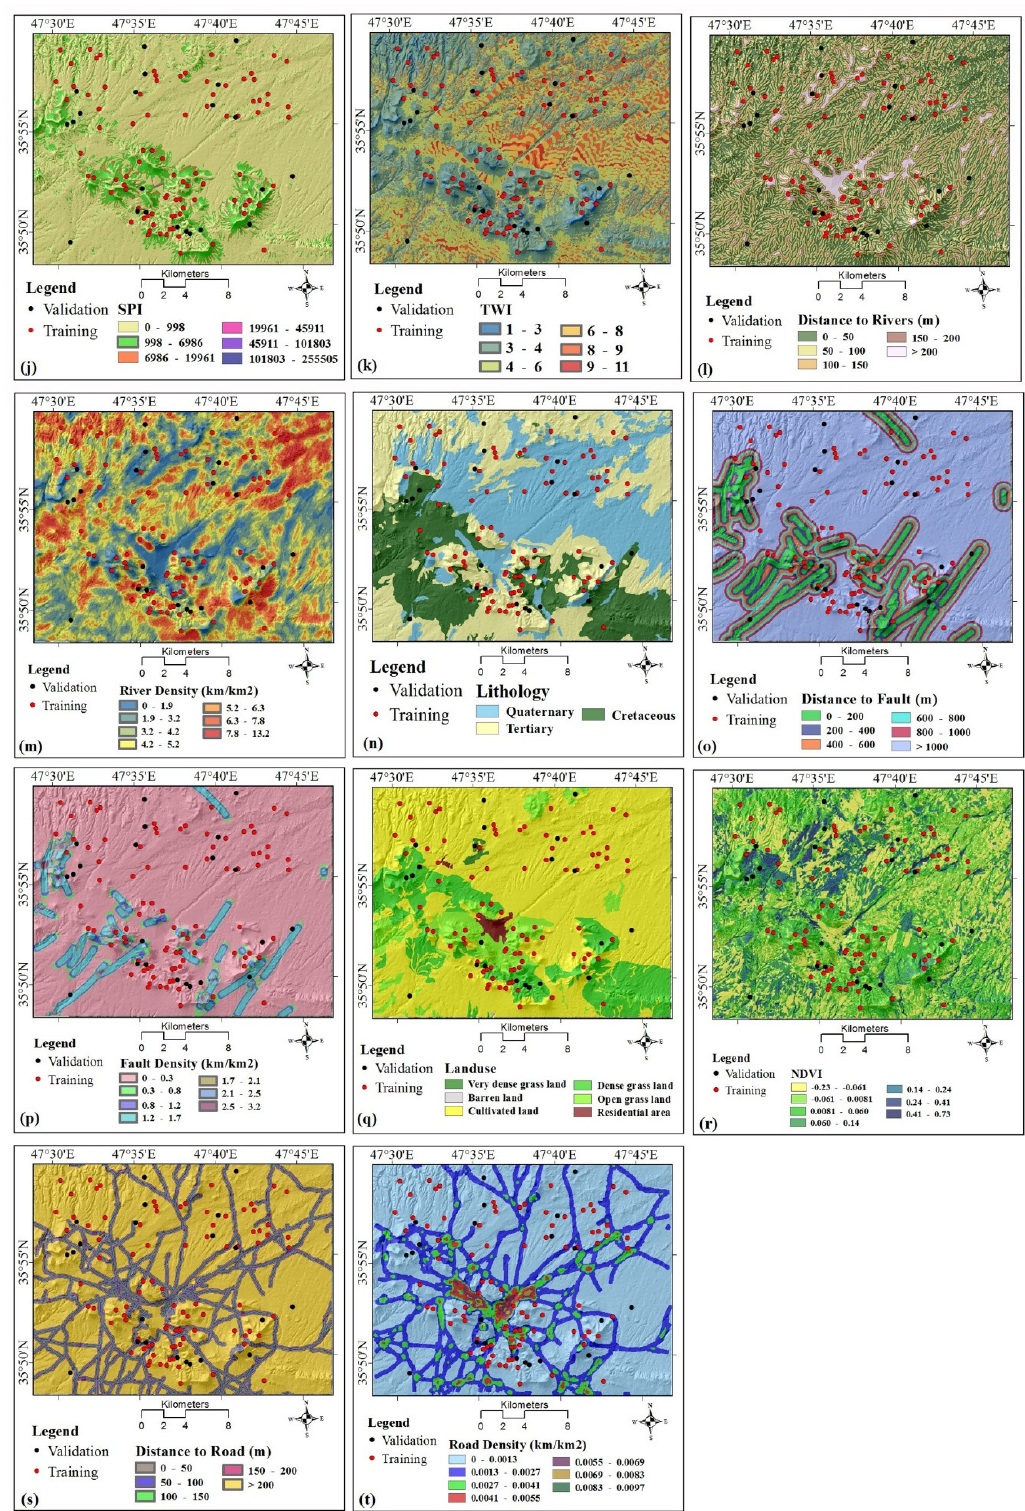
Figure 2. Landslide conditioning factors used in this study: ( a ) slope, ( b ) aspect, ( c ) elevation, ( d ) curvature, ( e ) plan curvature, ( f ) profile curvature, ( g ) slope length (SL), ( h ) rainfall, ( i ) annual solar radiation ( j ) stream power index (SPI), ( k ) topographic wetness index (TWI), ( l ) distance to rivers, ( m ) river density, ( n ) lithology, ( o ) distance to fault, ( p ) fault density, ( q ) land use, ( r ) normalized di ff erence vegetation index (NDVI), ( s ) distance to road, ( t ) road